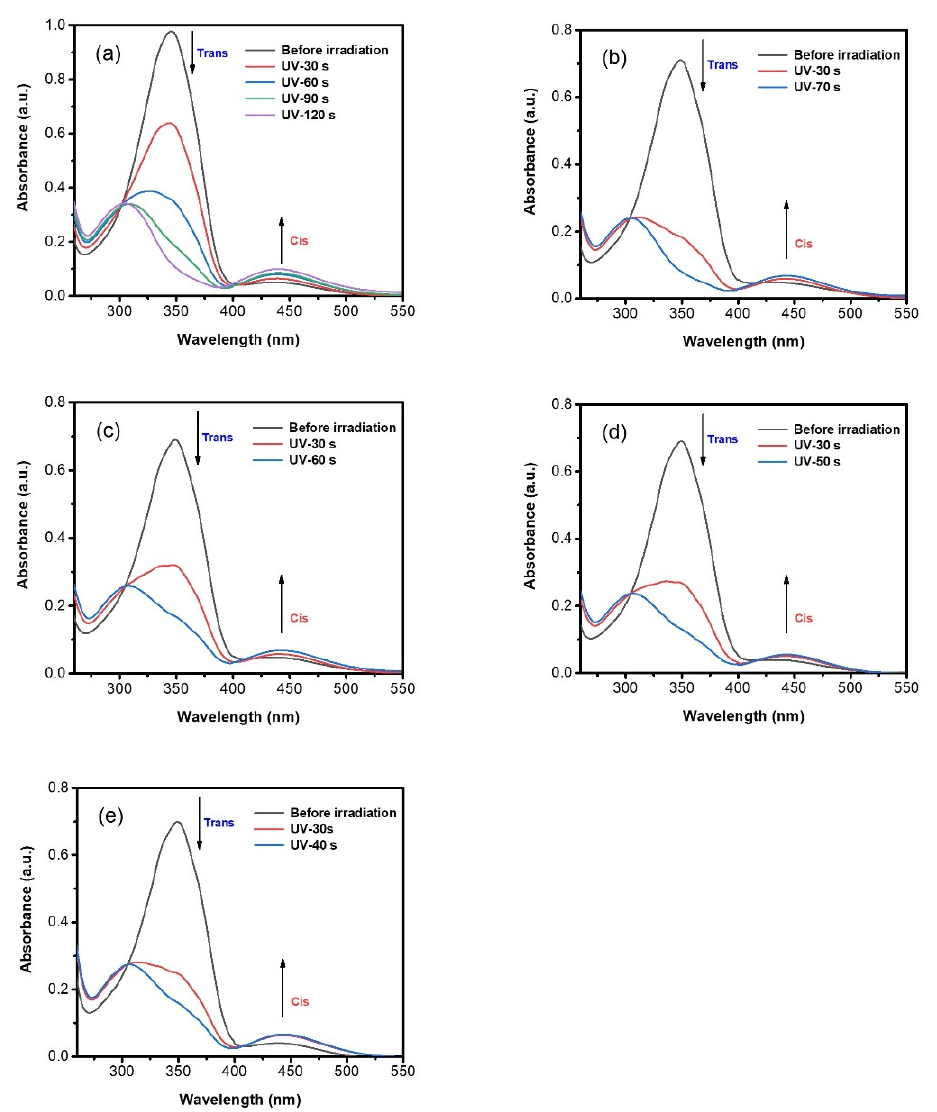
Figure 3. Absorption spectra of azopolymers P-n-Azo (n = 1~5, ( a – e )) after irradiation with 365 nm UV (5 mW / cm 2 ) light in ethyl acetate.